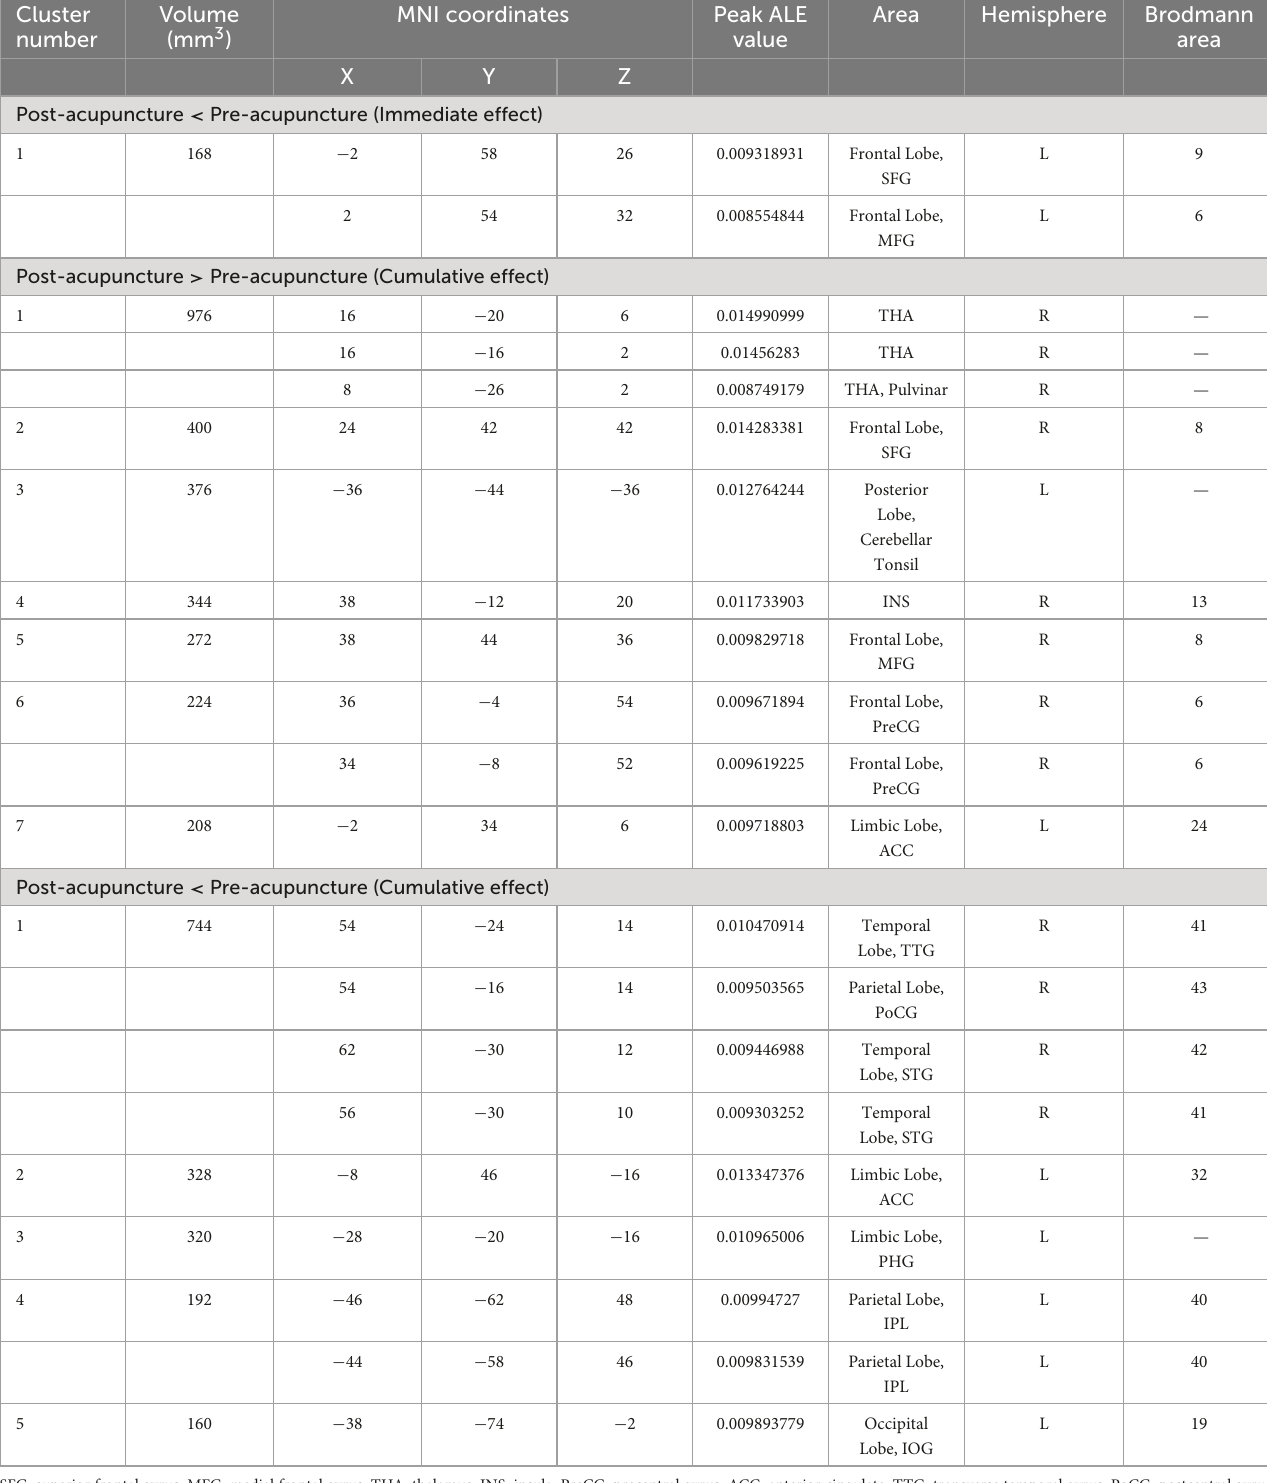
TABLE 4 Changes of brain activation in patients with pre- to post- acupuncture. Cluster